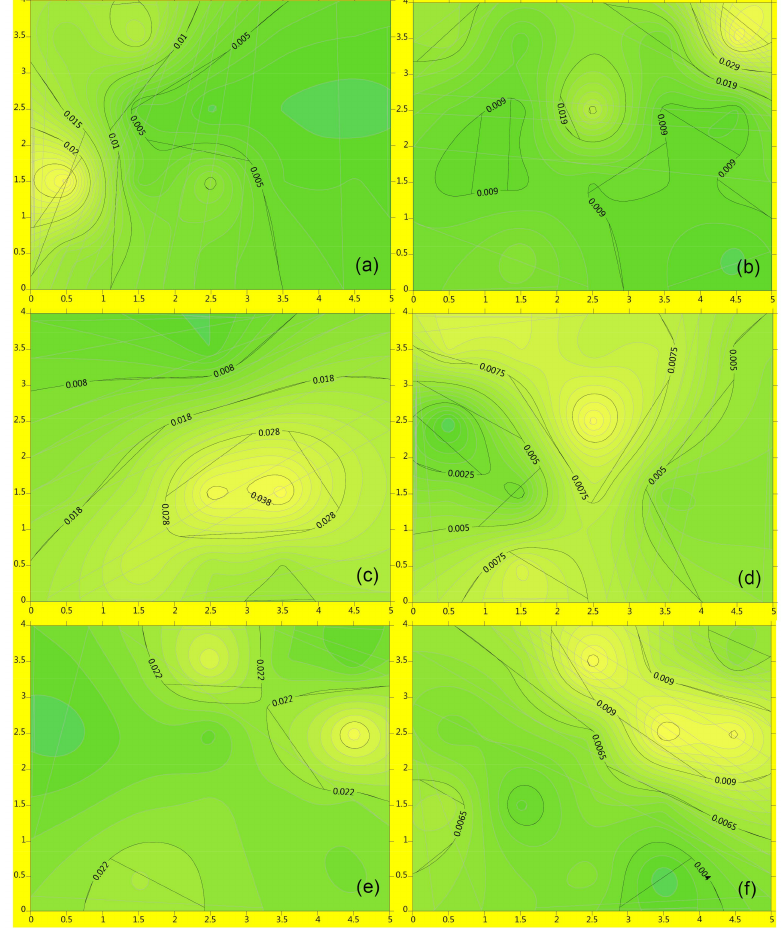
Figure 7. As concentration across the PRW sampled from 4/20/16 ( a ); 5/25/16 ( b ); 6/17/16 ( c ); 7/11/16 ( d ); 8/5/16 ( e ); and 10/19/16 ( f ). The location of wells was plotted in Figure 3. The flow direction is from the bottom, up. The units of values in the x- and y-axes are meters. The unit for the contour lines is mg/L of